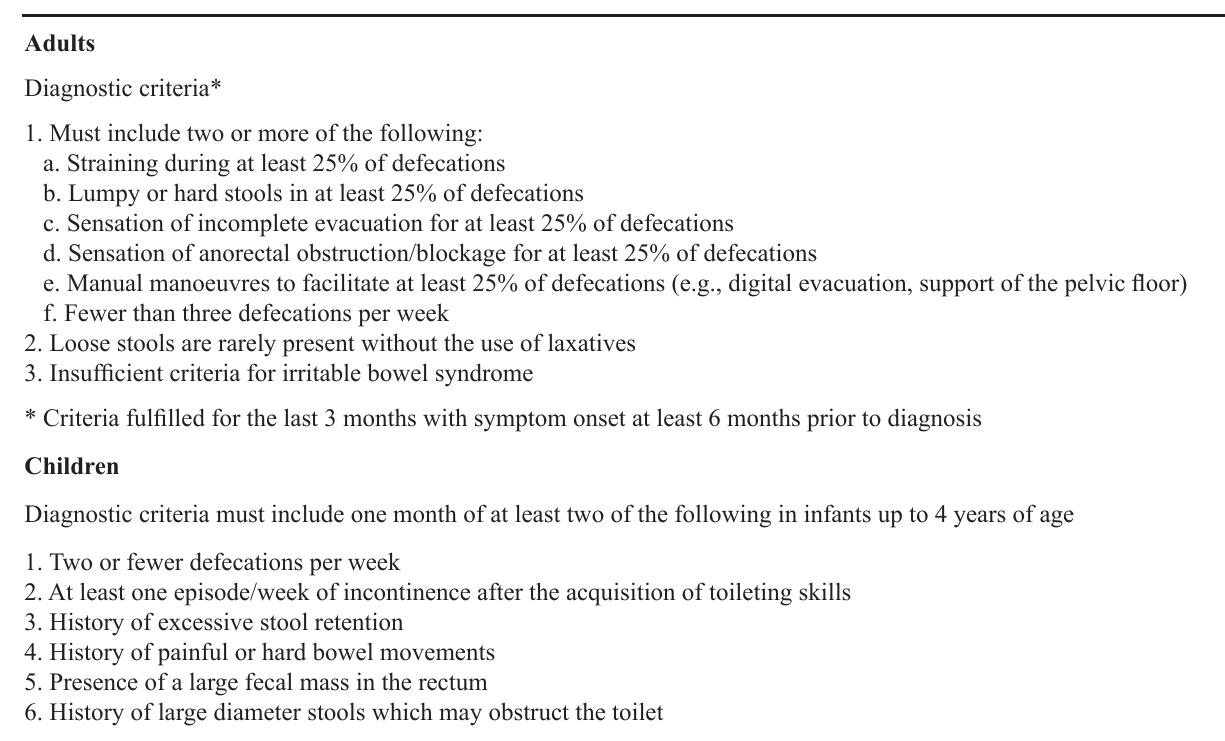
Table 1 – Rome III criteria for defining chronic functional constipation in adults and children